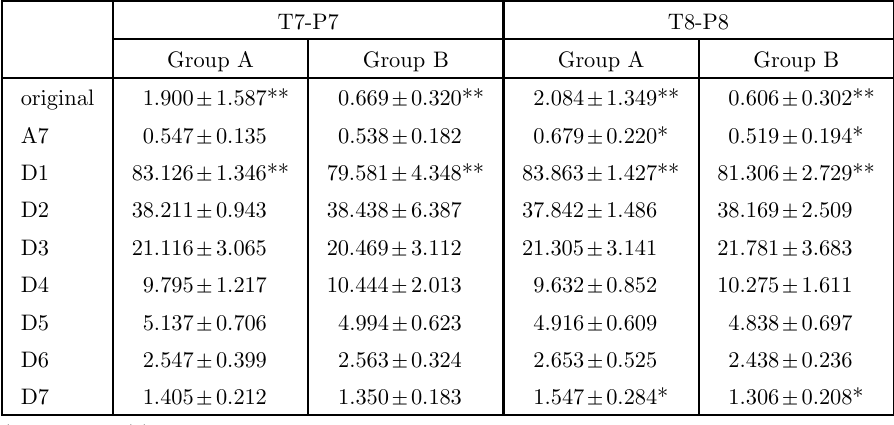
Table 2. The results of dominant frequencies for signals from channels T7-P7 and T8-P8 in studied groups (Mann-Whitney test) T7-P7 T8-P8 Group A Group B Group A Group B